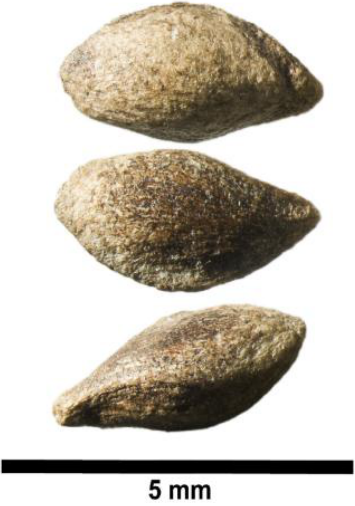
810 Fig. 6. Seeds of Larix found in core